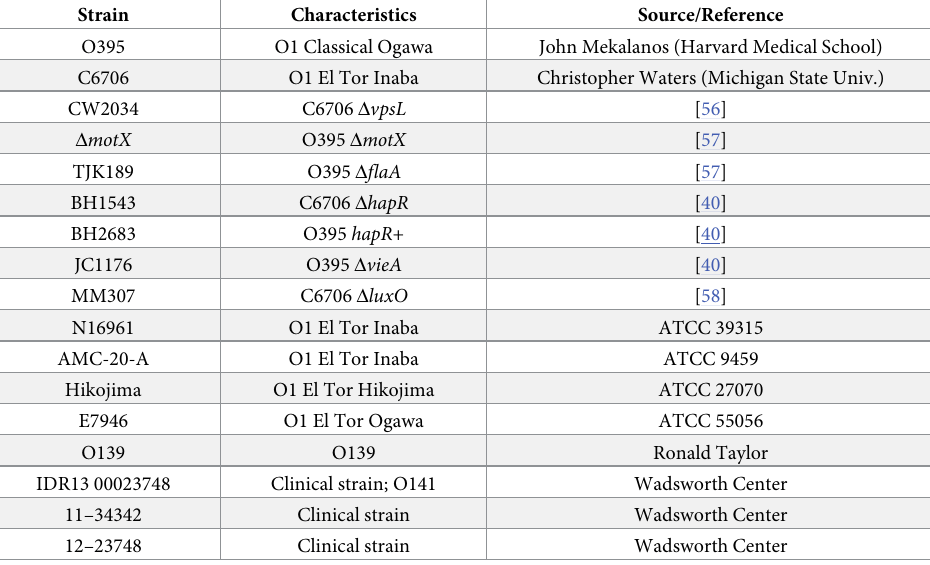
Table 2. V . cholerae strains used in this